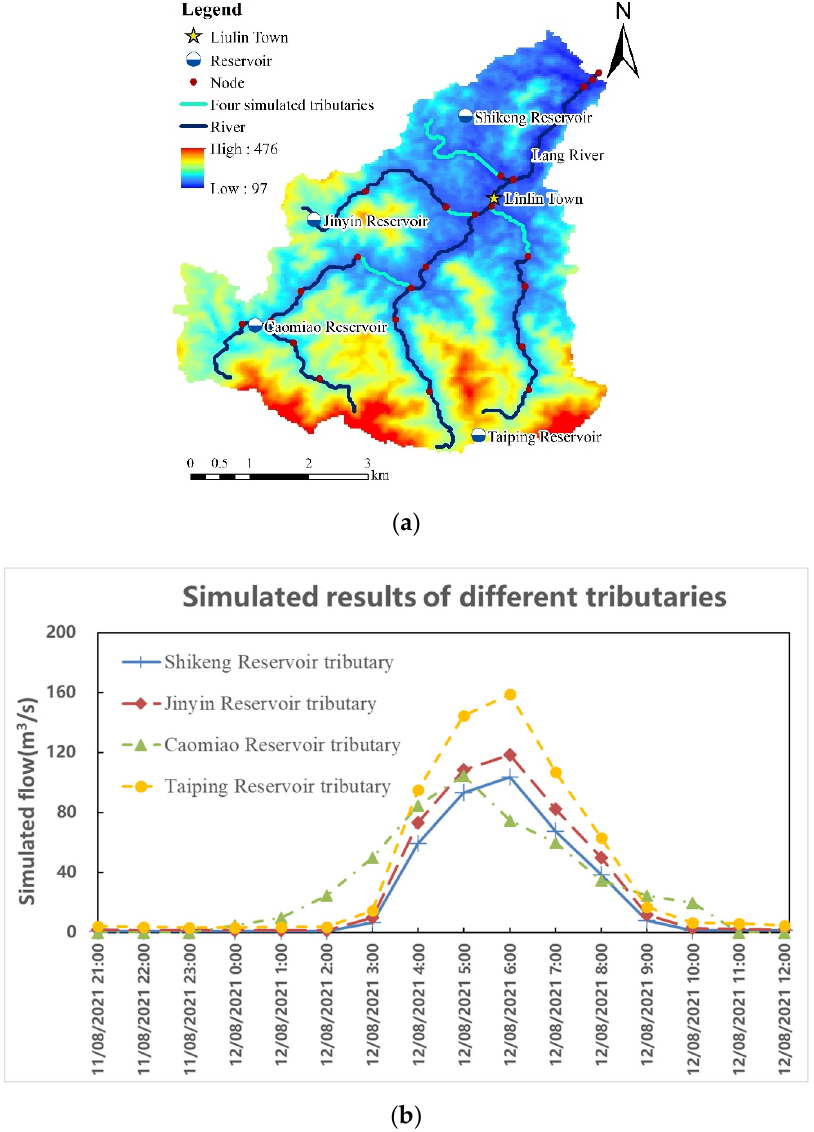
Figure 9. Distribution map ( a ); and simulation results of four tributaries of Lang River ( b ).